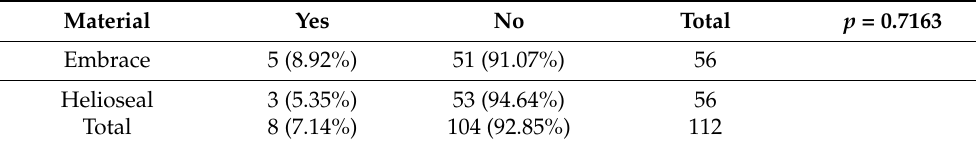
Table 8. Assessment of carious lesion after 24